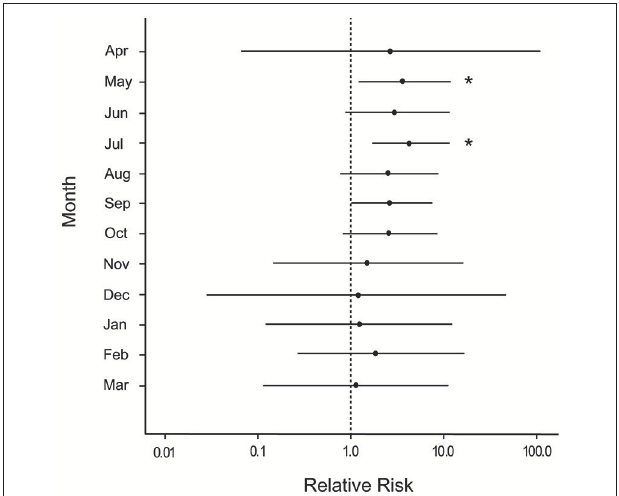
FIGURE 8 | Caterpillar plots depicting the median (black dot) and 95% credible intervals for the relative risk of white pox disease after damage from the March swells for colonies not occupied by the snail, Coralliophila abbreviata , at all sites combined. Asterisks indicate a statistically significant increase in disease